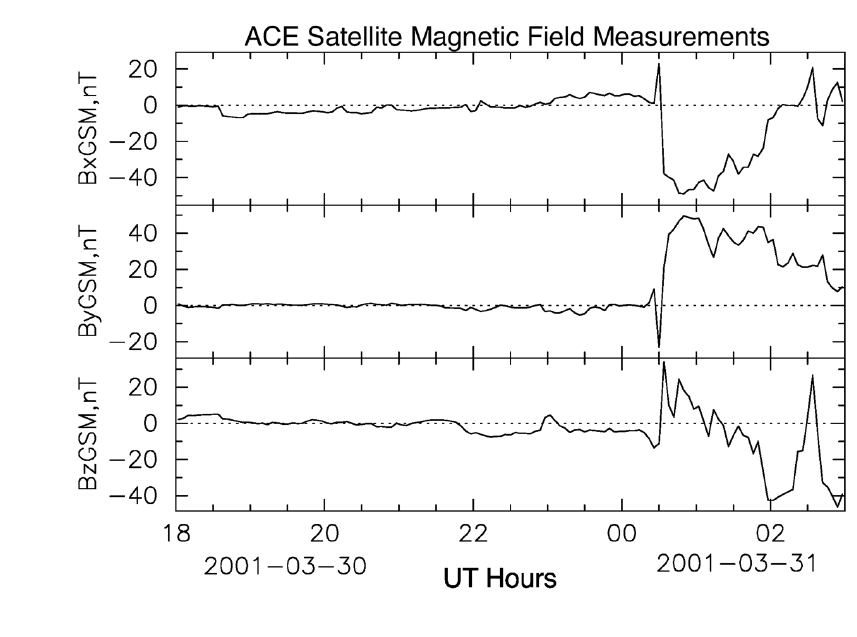
Fig. 9. Solar wind magnetic field components B x , B y , and B z in the GSM coordinates measured at the ACE spacecraft. Horizontal axis shows UT hours from 18:00 UT on 30 March to 03:00 UT on 31